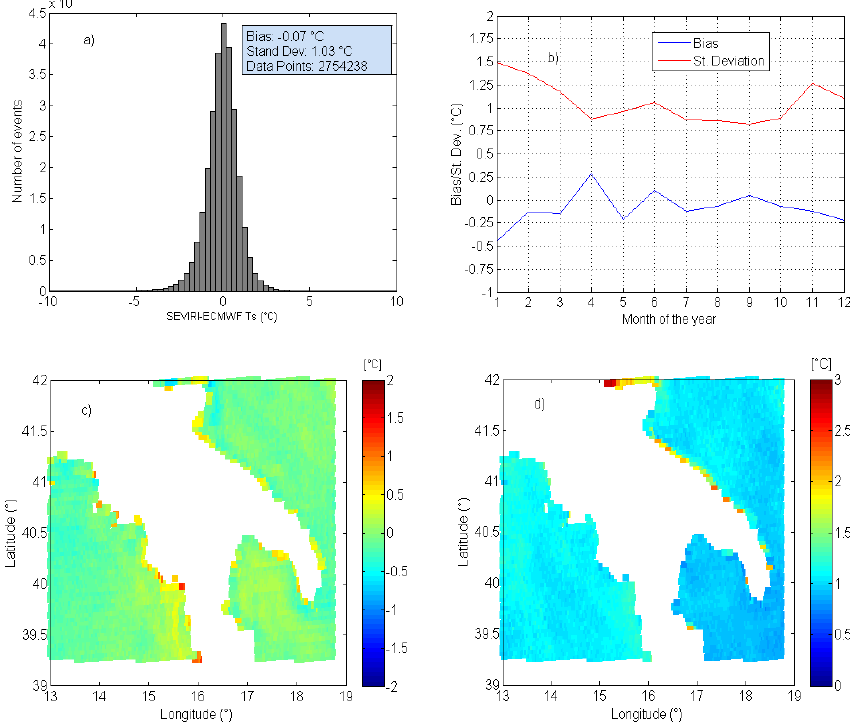
Figure 14. Year 2013. Comparison of SEVIRI-retrieved skin temperature with ECMWF analysis: (a) histogram of the surface temperature difference (cid:49)T s (SEVIRI–ECMWF), (b) monthly mean and related SD of (cid:49)T s , (c) Map of the yearly average surface temperature difference (SEVIRI–ECMWF) and related SD (d)